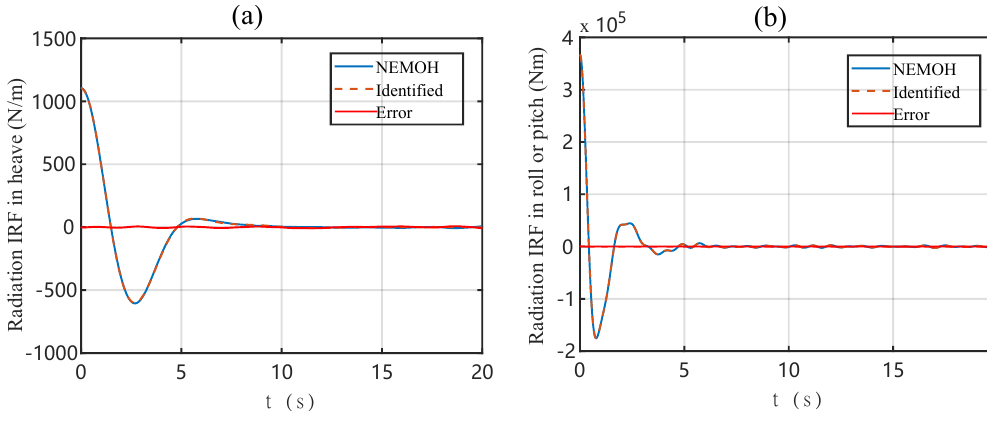
Fig. 3. Radiation approximation in (a) heave and (b) roll/pitch motions, respectively.